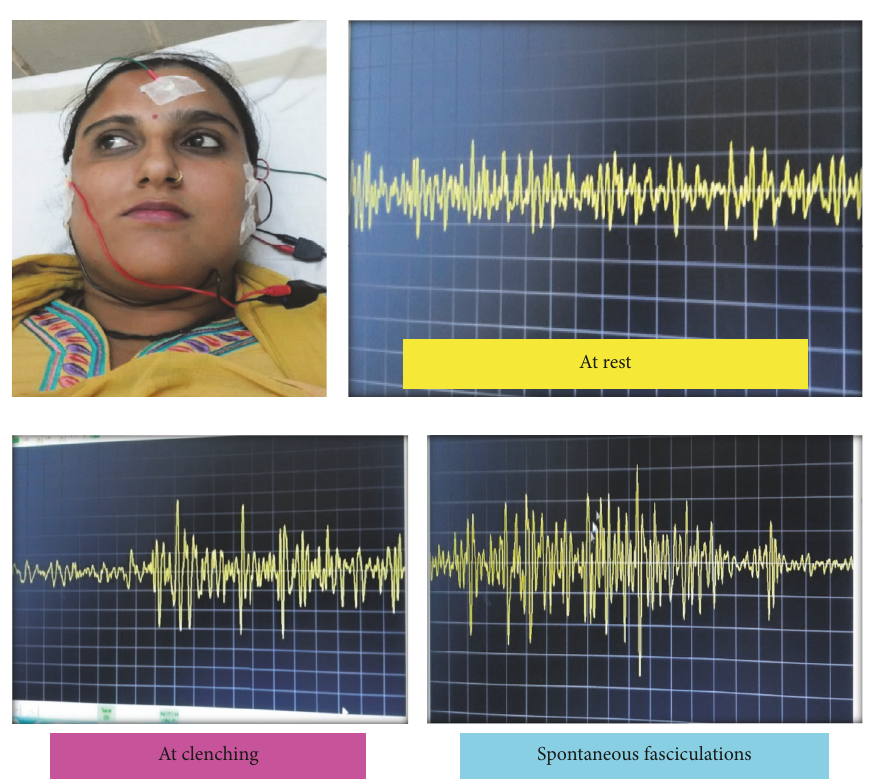
Figure 3: Electromyographic study of the bilateral temporalis and masseter reveals spontaneous fasciculations at rest.